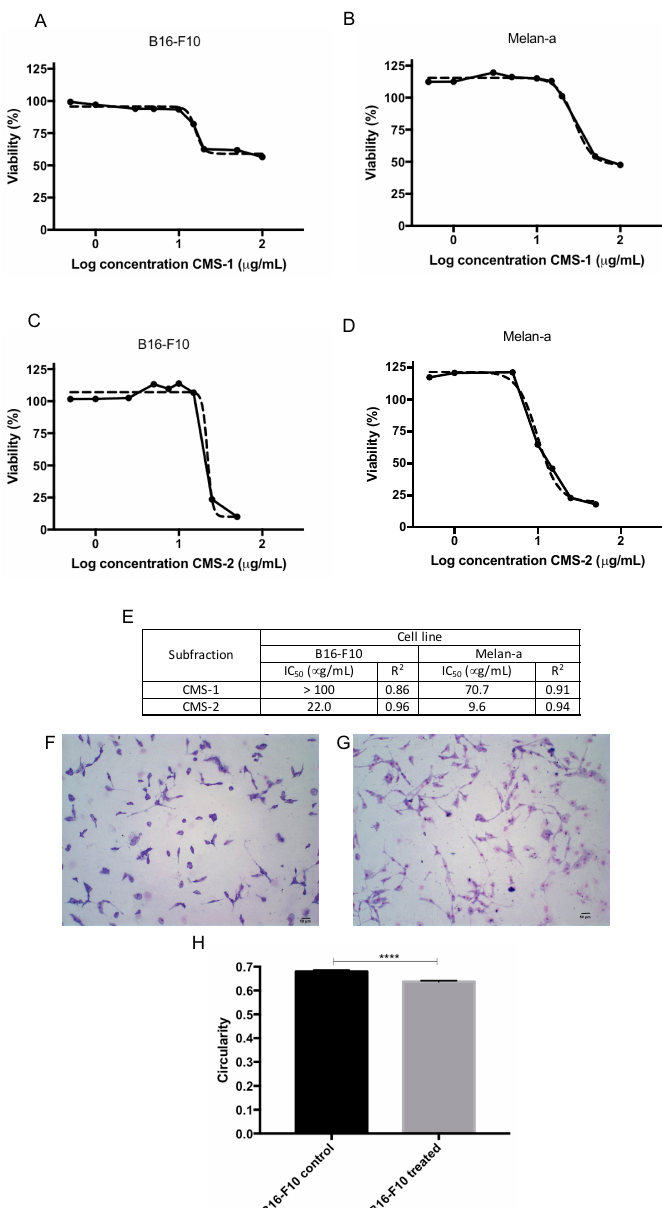
Figure 2. CMS ‐ 2, but not CMS ‐ 1, treatment reduces cell viability of murine melanoma and melanocyte. Cell viability was evaluated by Resazurin metabolism after 24 h of CMS ‐ 1 or CMS ‐ 2 exposure (0.5–100 μ g/mL) in: B16 ‐ F10 ( A , C ), respectively; or Melan ‐ a ( B , D ), respectively. Absorbance of Resazurin metabolite was spectrophotometrically quantified (570/600 nm) and half maximal inhibitory concentration (IC 50 ) was determined through non ‐ linear regression of Log concentration versus absorbance ( E ). ( F , G ) Representative images of B16 ‐ F10 treated with 10 μ g/mL CMS ‐ 2 after 24 h. CMS ‐ 2 treated cells ( G ) are more circular, quantified in ( H ), fusiform and dendritic compared to the control ( F ). ( H ) Cell circularity was quantified in B16 ‐ F10 cells treated with CMS ‐ 2 using ImageJ software. **** p < 0.001, t ‐ test, compared to B16 ‐ F10 control. 2.3. The Treatment with CMS ‐ 2 Alters the Expression of Proteins Related to Tumorigenesis and Formation of Metastasis To assess the differential protein expression between B16 ‐ F10 and Melan ‐ a (controls) and the corresponding cells treated with 10 μ g/mL CMS ‐ 2, a two ‐ dimensional DIGE assay was conducted